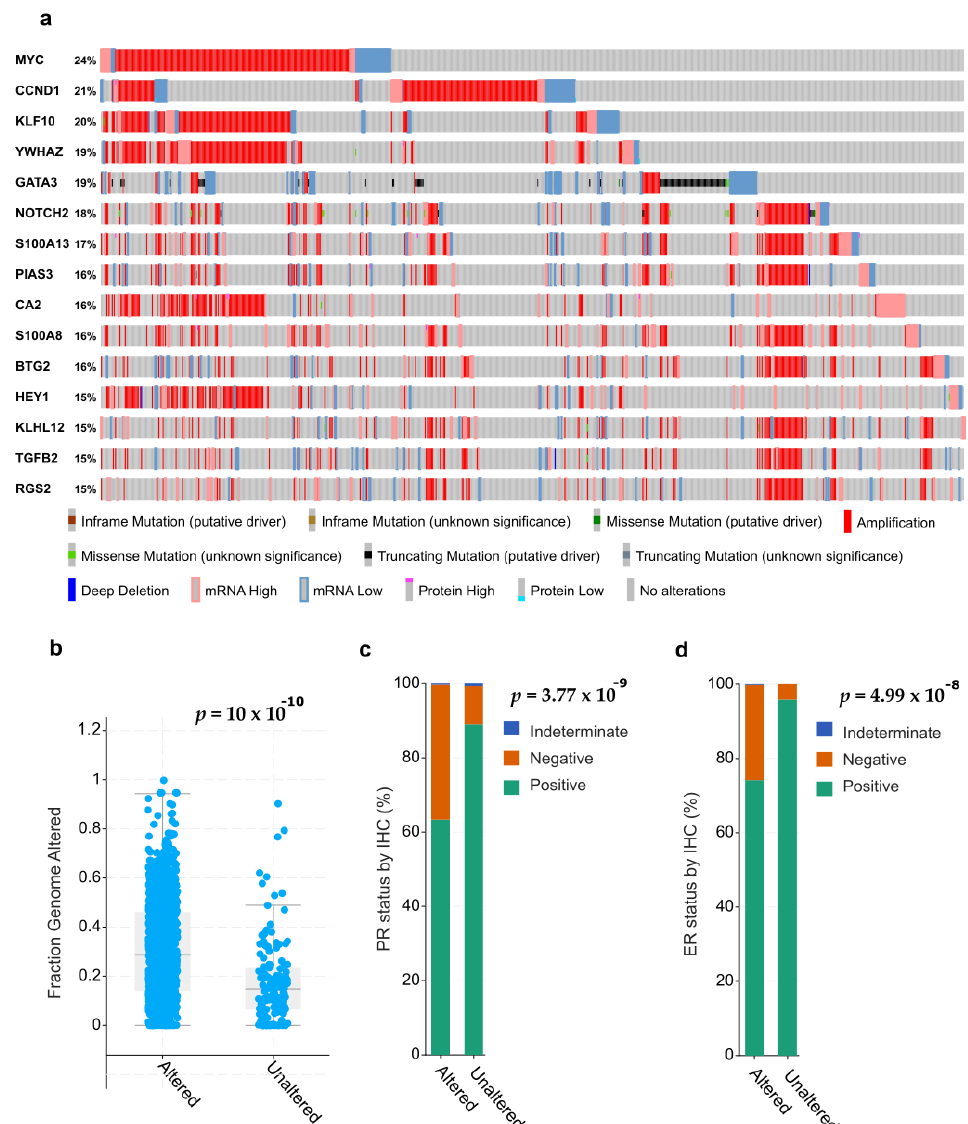
Figure 4. Analysis of the 12 most frequently mutated genes associated simultaneously with Notch signaling and EMT, in 1039 breast cancers (TCGA sequencing project). In contrast to Figure 3, tumors have been sorted according to most frequent mutations (CCND1, MYC) to illustrate the high frequency of amplifications. ( a ) Sorted incidence of mutations, including amplifications, deletions, point mutations, and RNA overexpression, as generated by the cBioPortal browser. Data have been sorted according to type of mutation/genetic alteration. ( b ) Tumors with high frequency of genetic alterations in Notch/EMT target or signature genes also show a higher degree of genetic instability. ( c ) Tumors with high levels of Notch/EMT-related genetic alterations more frequently belong to the triple-negative and basal-like breast cancers that lack expression of progesterone receptor (PR). ( d ) Corresponding finding for expression of estrogen receptor (ER) in the same tumors, as analyzed by immunohistochemistry (IHC).